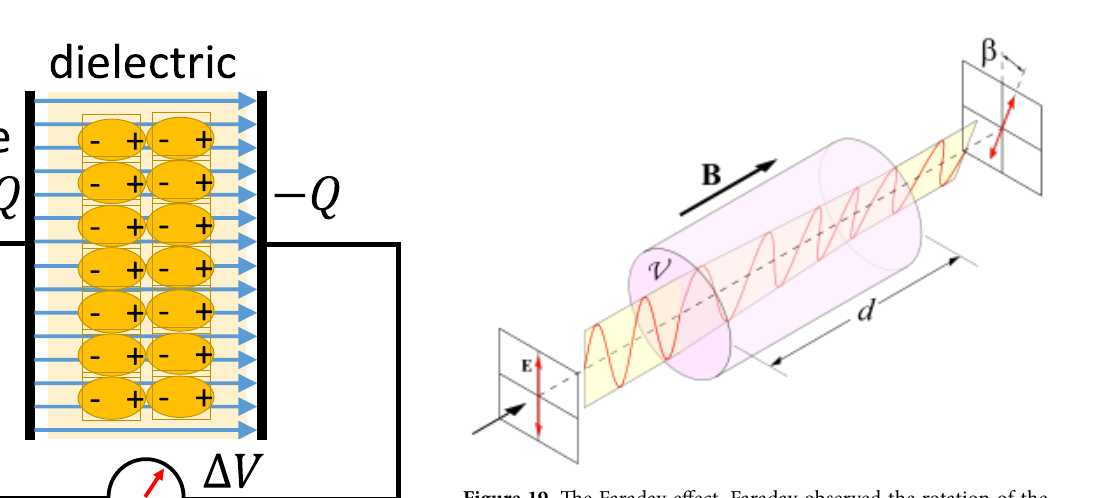
Figure 19. The Faraday effect. Faraday observed the rotation of the polarization plane of the light when this crosses a glassy material (lead silicoborate) subjected to an intense magnetic field: this effect is due to interaction of the light (electromagnetic wave) with the electrons present in the glass atoms. The phenomenon is the basis of the microwave technology and of optical insulators used in mod- ern communications technologies